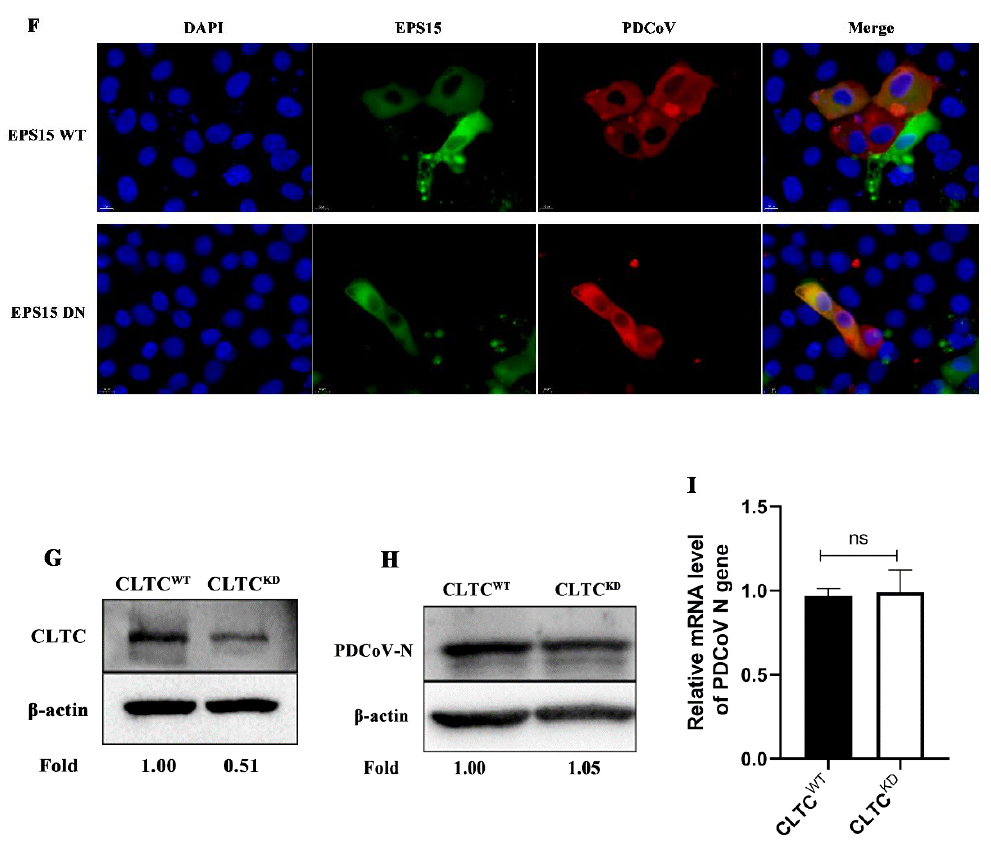
Figure 1. PDCoV entry into porcine kidney (PK-15) cells does not depend on the clathrin-mediated endocytosis pathway ( A ). PK-15 cells were pretreated with chlorpromazine (CPZ) at 37 ◦ C for 1 h and infected with PDCoV (MOI of 5) at 4 ◦ C for 1 h (binding step), and then shifted to 37 ◦ C for 1 h (entry step). Cells were lysed to determine viral mRNA level by qRT-PCR. ( B , C ). Cells were mock-treated or treated with CPZ for 1 h followed by infection with PDCoV (MOI = 0.1). At 24 hpi, mRNA expression levels of total PDCoV were detected by RT-qPCR ( B ) and protein expression levels of intracellular PDCoV were detected by Western blotting ( C ). ( D ) PK-15 cells were pretreated with CPZ with different concentrations at 37 ◦ C for 1 h, followed by incubation with 10 µ g/mL Alexa Fluor 568-labeled transferrin (Tfn) on ice for 30 min, then shifted to 37 ◦ C for 30 min. The cells were fixed and stained with DAPI (Scale bar, 20 µ m). ( E , F ) PK-15 cells were transfected with EPS15 wild type (WT) or EPS15 dominant-negative (DN), followed by incubation with 10 µ g/mL Tfn or infection with PDCoV (MOI = 0.1). At 24 hpi, the cells were fixed and immunostained (Scale bar, 10 µ m). ( G – I ) Clathrin heavy-chain knockdown cells and normal cells were infected with PDCoV (MOI = 0.1). Knockdown efficiency was verified with Western blotting ( G ). At 24 hpi, the viral N protein and viral RNA levels were determined by Western blotting ( H ) and qRT-PCR ( I ), respectively. ns: there was no significant difference.